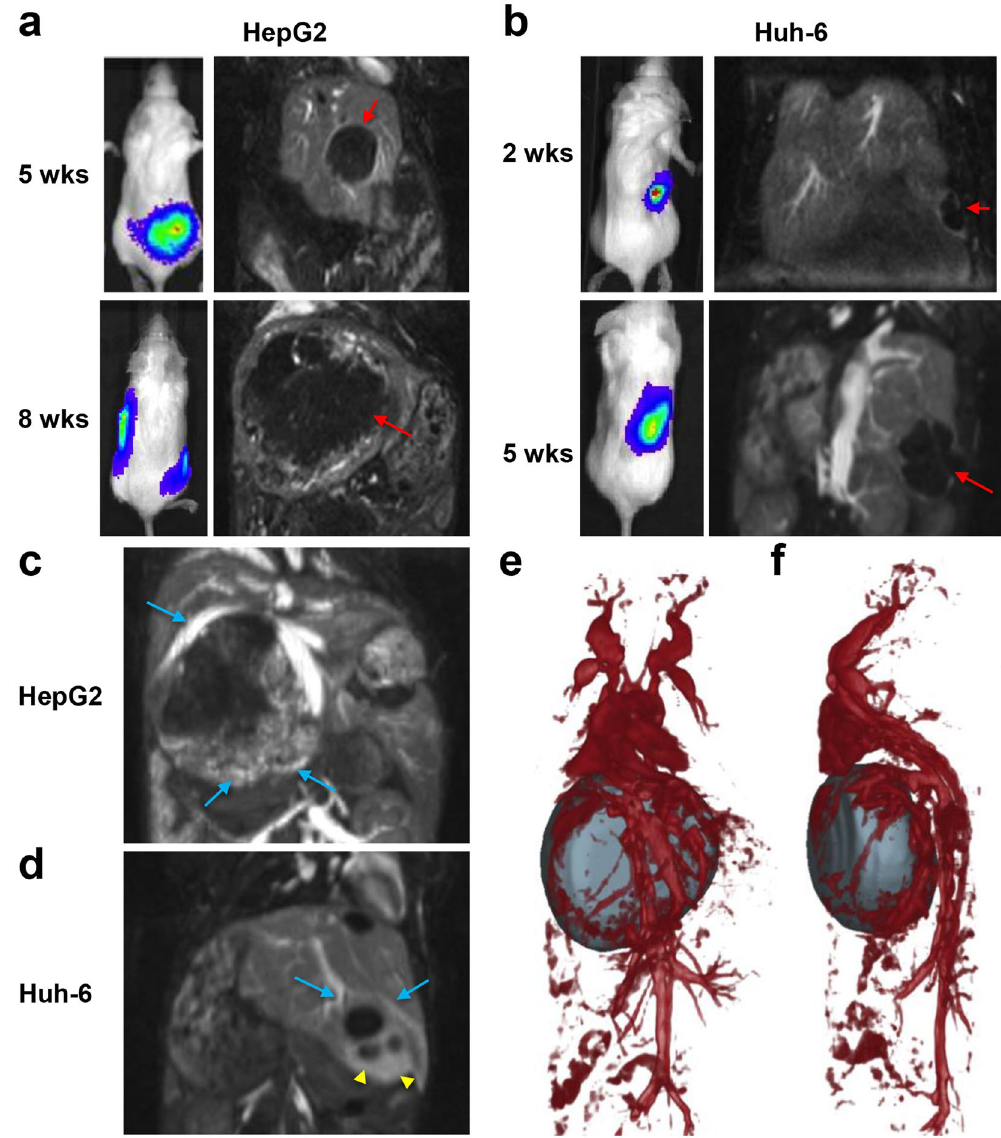
Figure 3. MRI of xenograft tumors and tumor-associated vasculature. ( a , b ) Representative contrast-enhanced T1-weighted coronal images showing the presence of tumor masses (red arrows) at early and late time points. Representative BLI images acquired on the same day are shown for comparison. ( c , d ) Representative contrast-enhanced T1-weighted coronal thick slab maximum intensity projection (MIP) abdominal images demonstrating the presence of increased vascularity (blue arrows) and highly permeable vessels (yellow arrowheads) in the peripheral regions of the tumors. ( e , f ) Coronal ( e ) and sagittal ( f ) 3D volume rendering MRI of HepG2 tumor and major hepatic blood